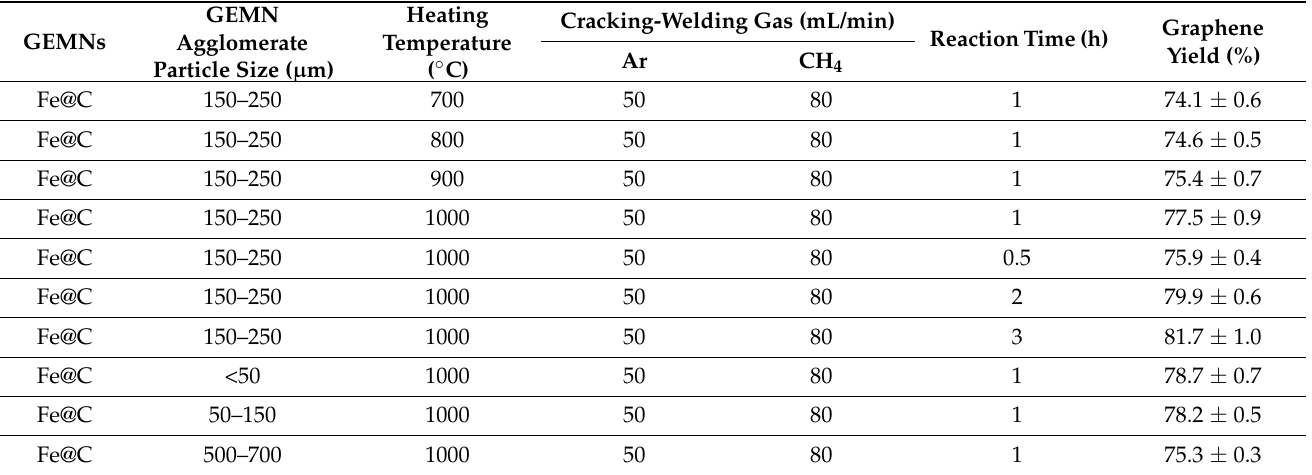
Table 1. Graphene-based materials from graphene-encapsulated iron nanoparticles (GEINs). The “@C” indicates the carbon (graphene)